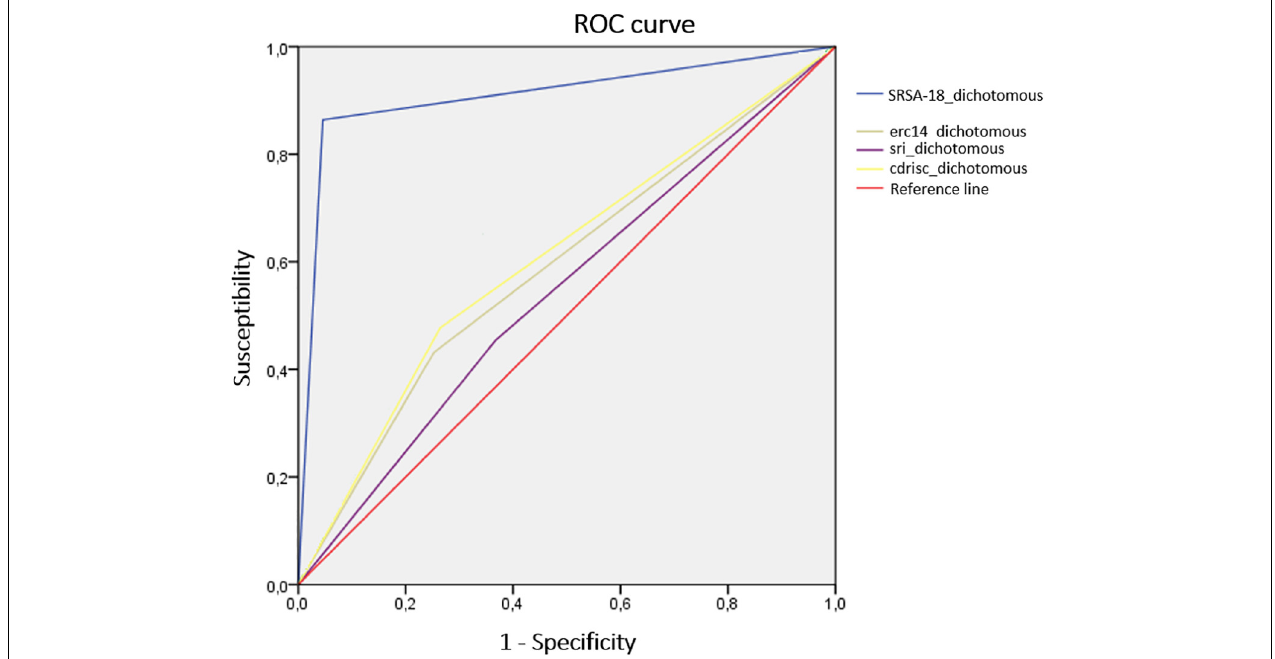
FIGURE 2 | Area under the ROC curve of dichotomized resilience.